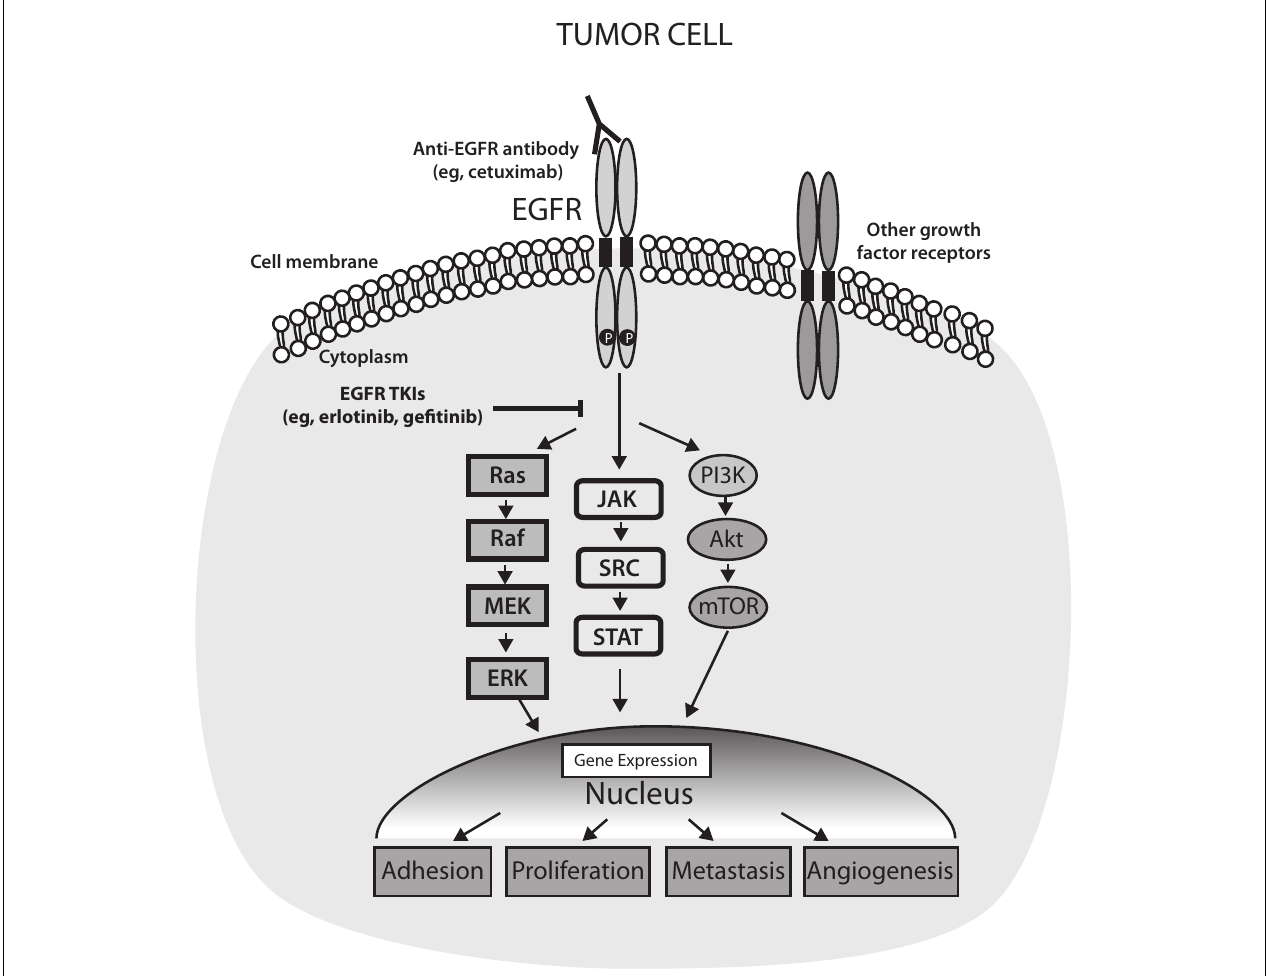
oncogene homolog 1; EGFR, epidermal growth factor receptor; ERK, extracellular regulated kinase; JAK, Janus kinase; MEK, MAP kinase–ERK kinase; mTOR, mammalian target of rapamycin; PI3K, phosphatidylinositol 3-kinase; Ras, rat sarcoma viral oncogene homolog; Raf, v-raf-1 murine leukemia viral oncogene homolog 1; SRC, Rous sarcoma oncogene; STAT, signal transducer, and activator of transcription;TKIs, tyrosine kinase inhibitors. Adapted from Box 2 in Nyati et al. (2006) and Figure 2 in Marshall